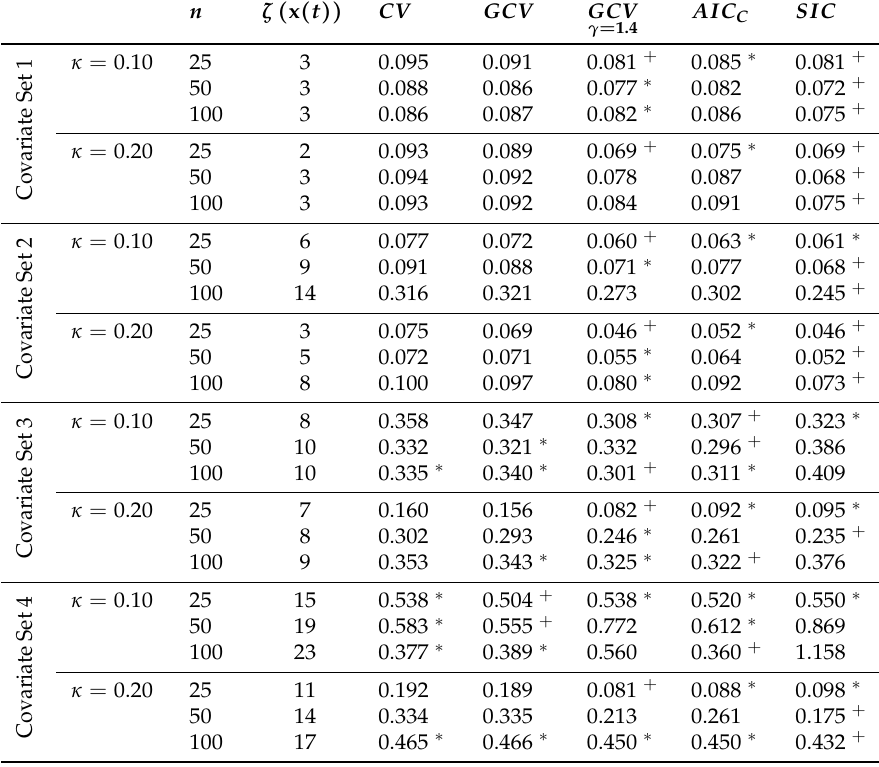
Table 3. Analogous to Table 1 for parameter curve β 3 ( t )